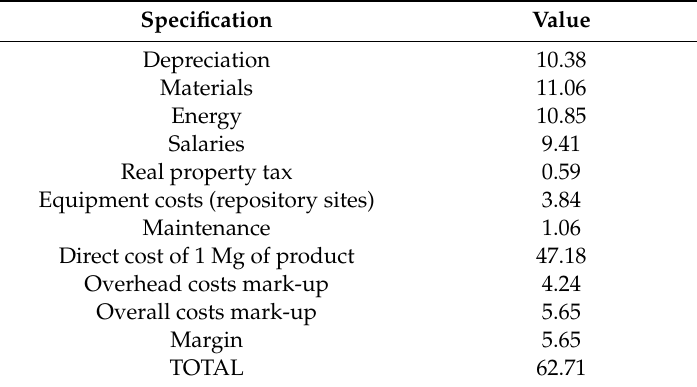
Table 4. Operational costs and mark-up (EUR / Mg of the product).